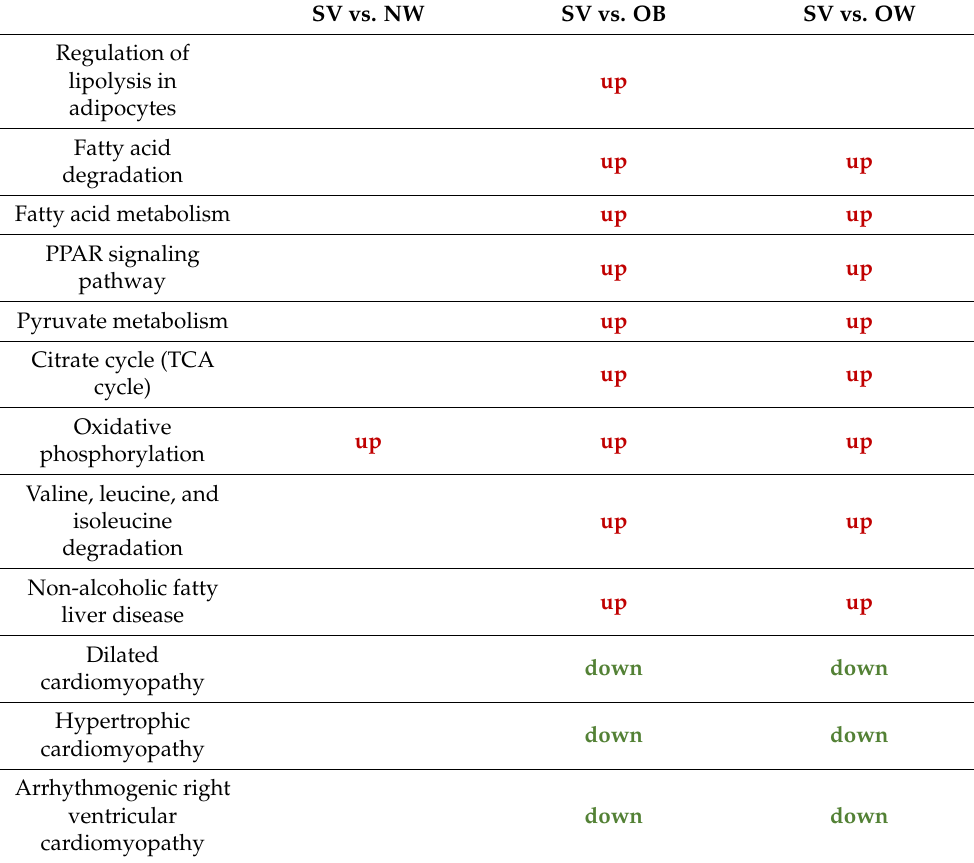
Table 3. GSEA analysis. Pathways deregulated in the SV vs. NW, OB, or OW comparisons. The pathways are listed according to the grouping target involved in the same metabolic path. Green font indicated downregulated pathways; red font indicates upregulated pathways. SV vs. NW SV vs. OB SV vs.